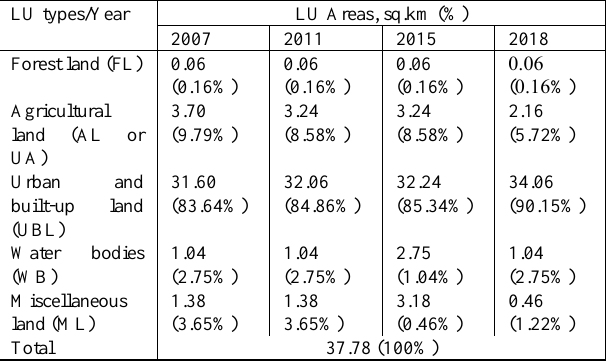
Table 3. Summary statistics of MNC land use of Thailand classified into the five